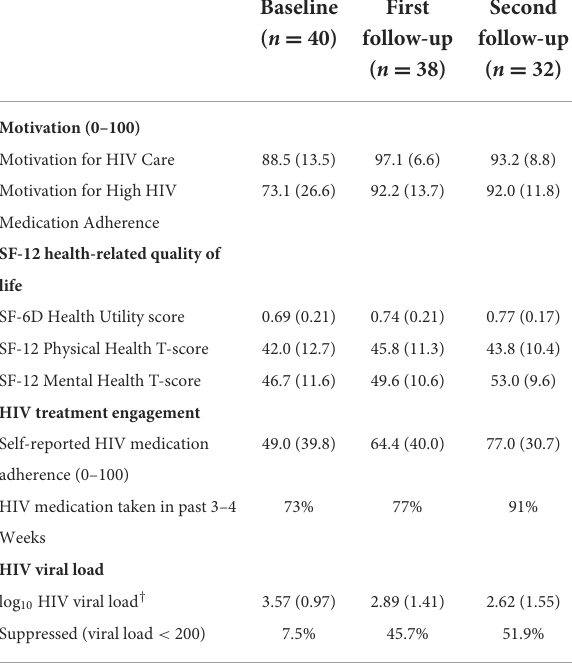
TABLE 6 Motivation, health-related quality of life, HIV care engagement, and HIV viral load over time [mean (SD) or percent].